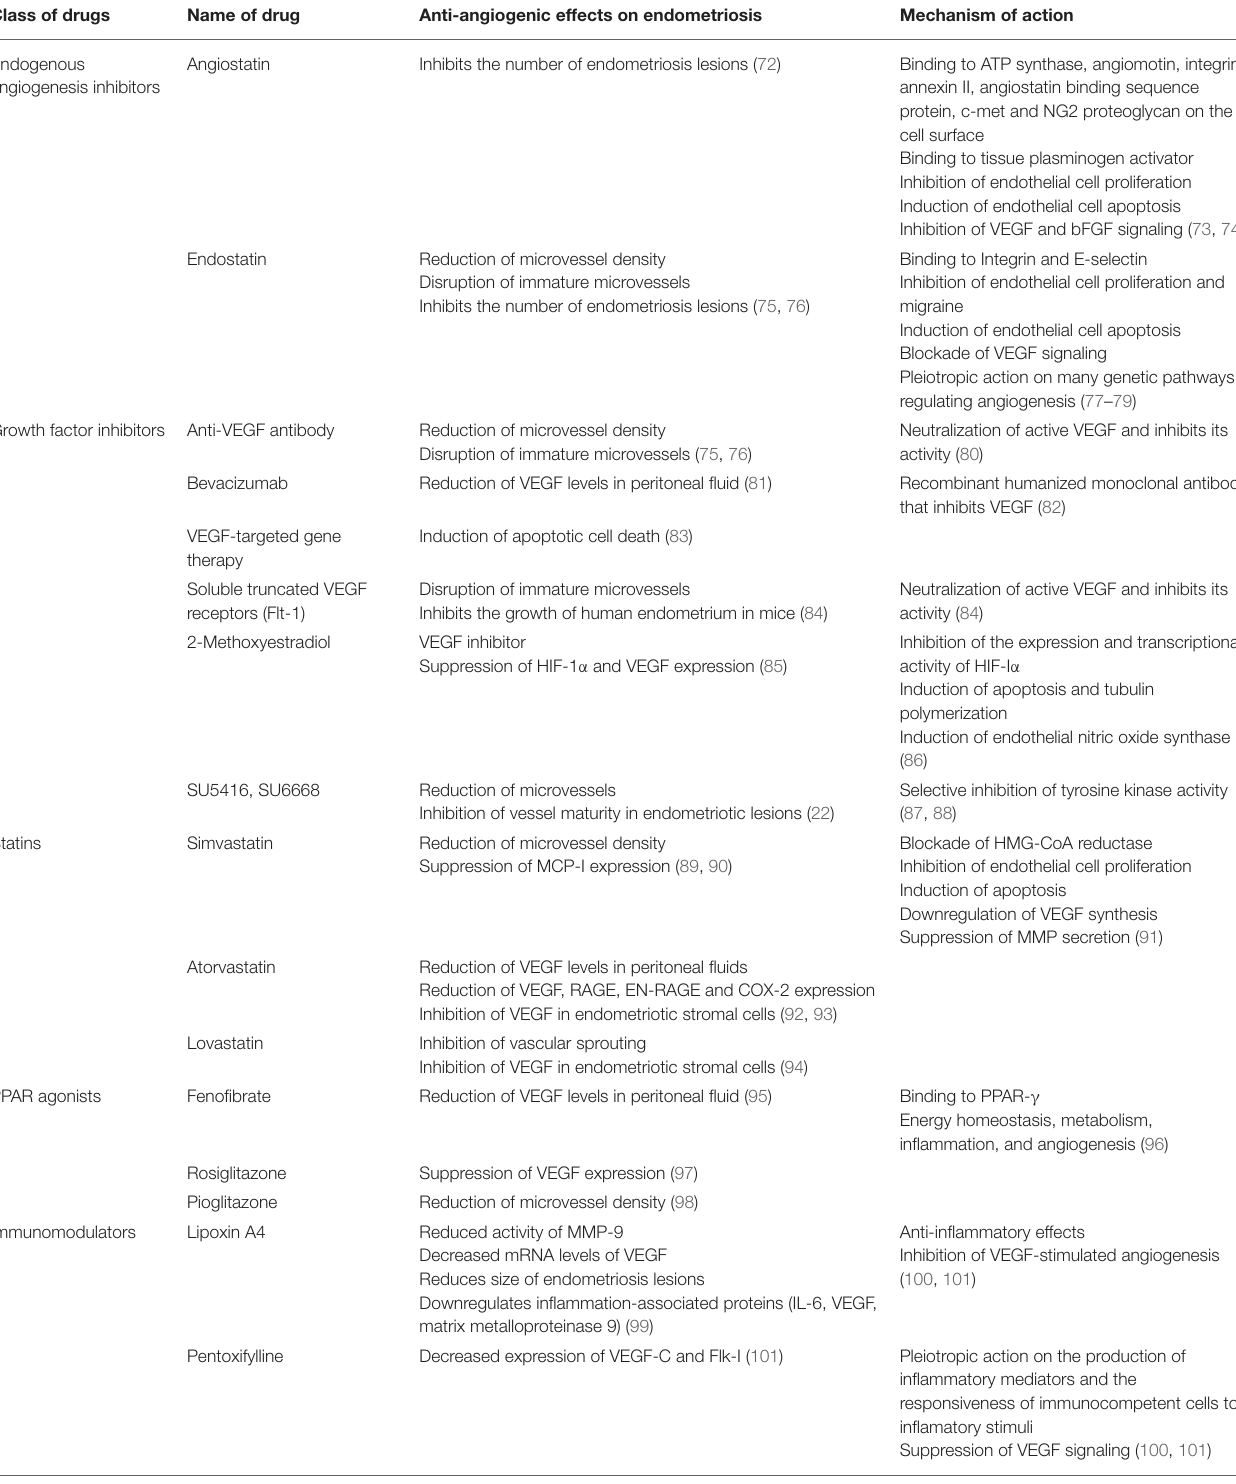
TABLE 1 | Anti-angiogenic therapy and their mechanisms of